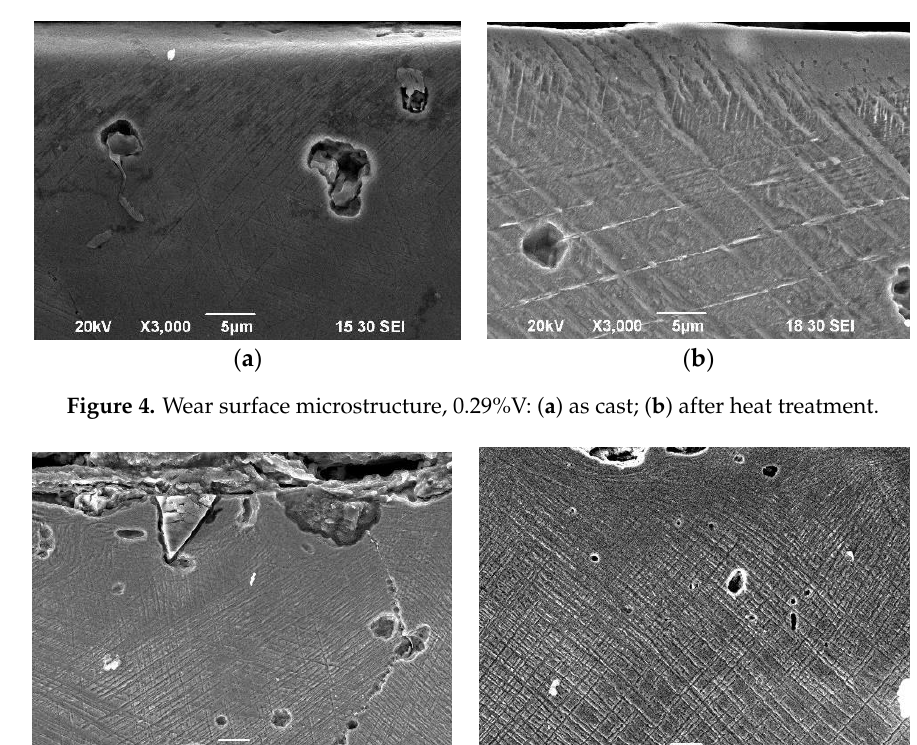
Figure 3. Nitrogen recovery rate in high manganese steel at cooling rates within the crystallization